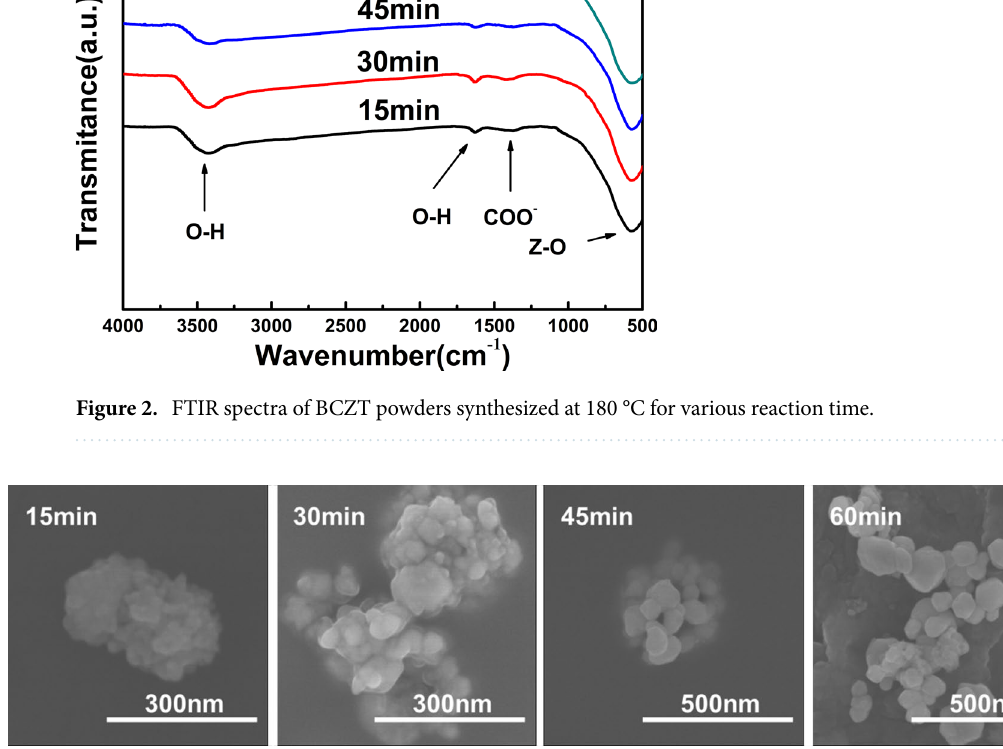
Figure 3. SEM images of BCZT powders synthesized at 180 °C for various reaction